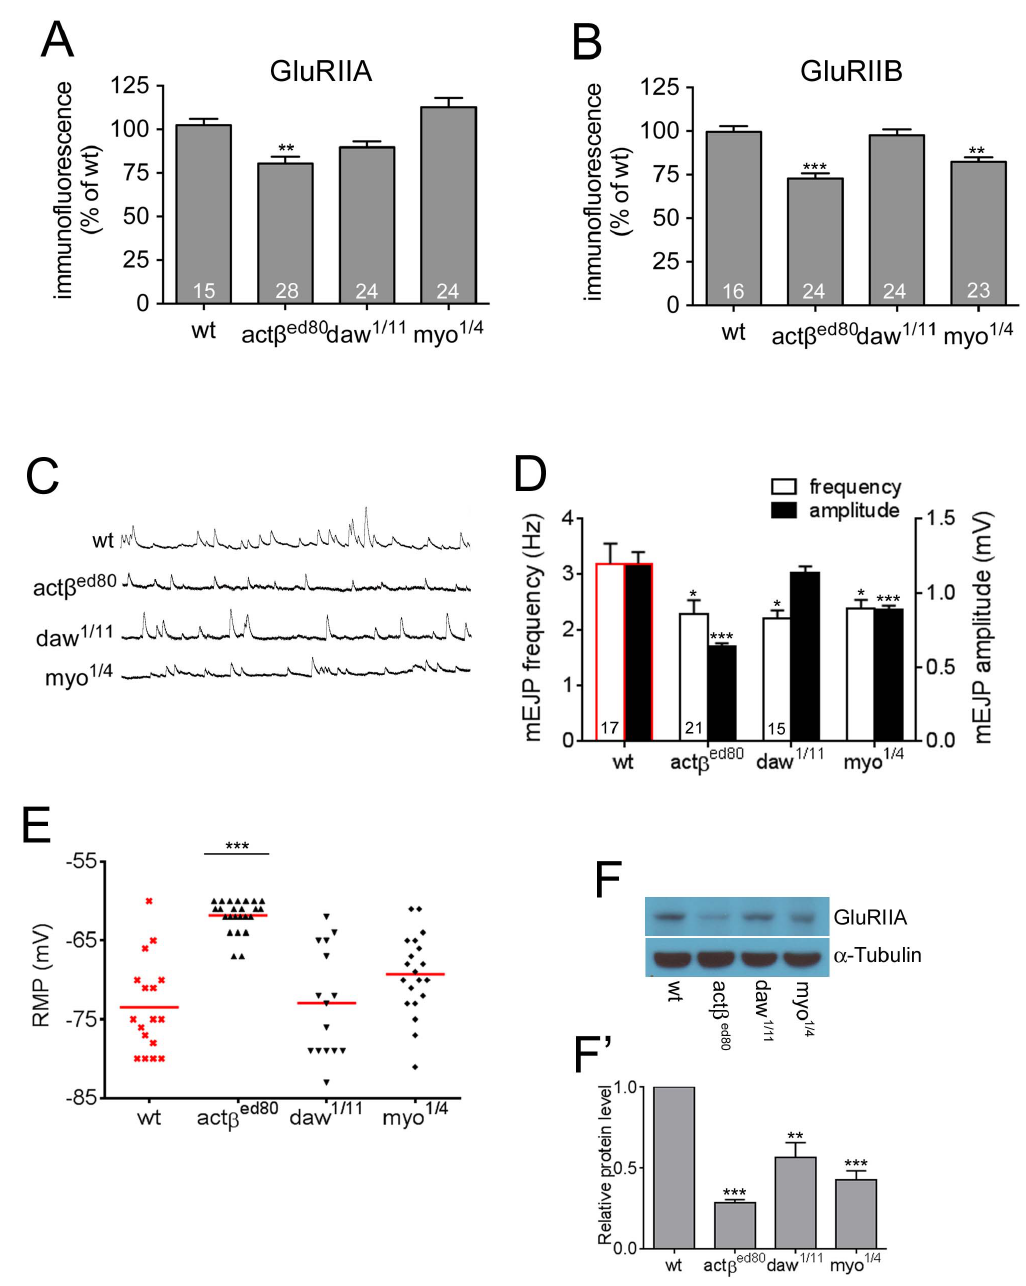
Figure 6. Among the Activin-type ligands, a mutation in act b causes the most severe phenotypes. (A) Synaptic GluRIIA levels are decreased greatly in act b and slightly in daw mutants but not in myo mutants. (B) Decreased GluRIIB levels in Activin-type ligand mutants. The greatest decrease is shown by act b mutants. (C) Representative traces of mEJPs of wild-type and Activin/TGF- b ligand mutants. (D) Quantification of mEJP size and frequency. (E) Distribution of the resting membrane potentials. The act b mutants show the most depolarized resting membrane potentials. (F and F 9 ) Total protein level of GluRIIA. A representative blot image (F) and quantification (F 9 ). Error bars represent SEM. *p , 0.05, **p , 0.01, ***p , 0.001 from One-way ANOVA followed by Dunnett’s multiple comparison test. Each genotype was compared to the wild-type. Data sets of wild-type shown in Fig. 2 were included in D and E for reference and marked with red.